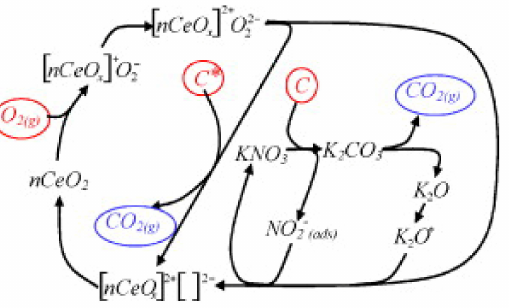
Figure 12. Reaction network for soot oxidation on K/CeO 2 catalysts [118]. Copyright 2009,